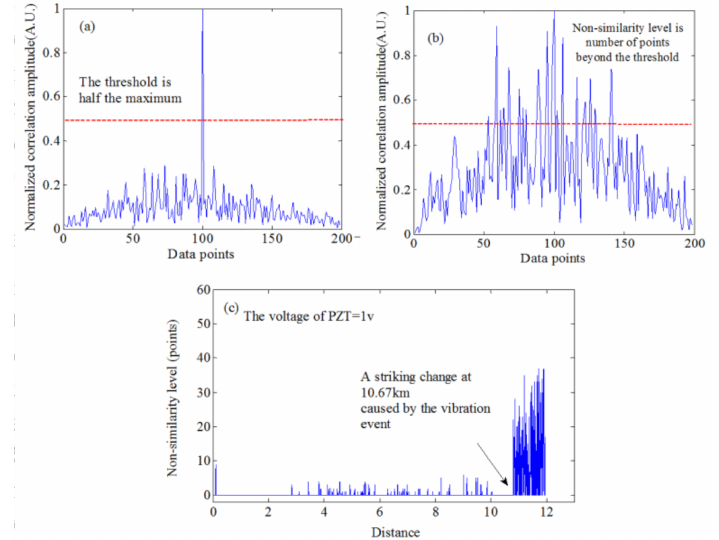
Figure 19. Cross-correlation between local Rayleigh backscattering in the spatial domain at the non-vibrated state and vibrated state: ( a ) not at the vibration location, ( b ) at the vibration location. A “non-similarity level” is number of points beyond a set threshold. ( c ) Measured distributed “non-similarity level” as a function of FUT length (reprinted from Ding et al. [53] with permission of OSA; copyright